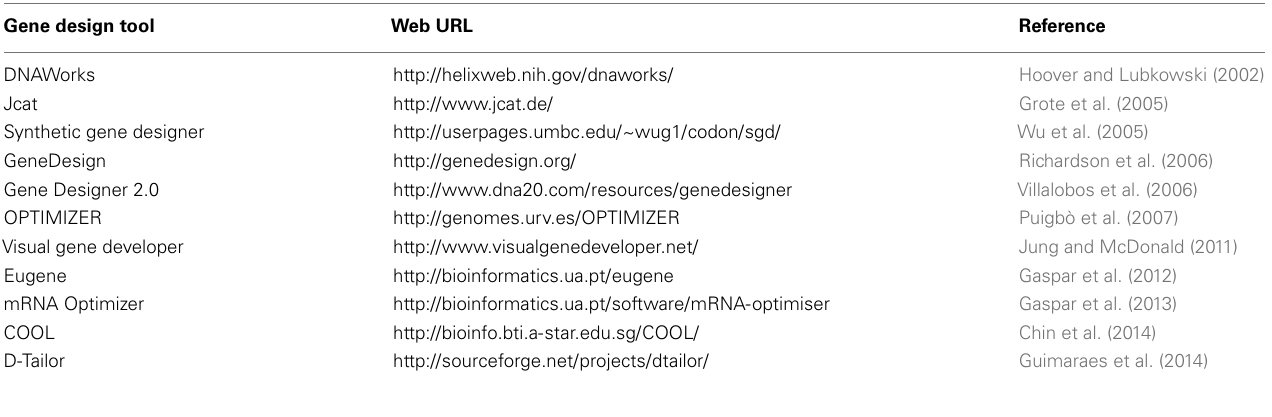
Table 1 | Gene design tools